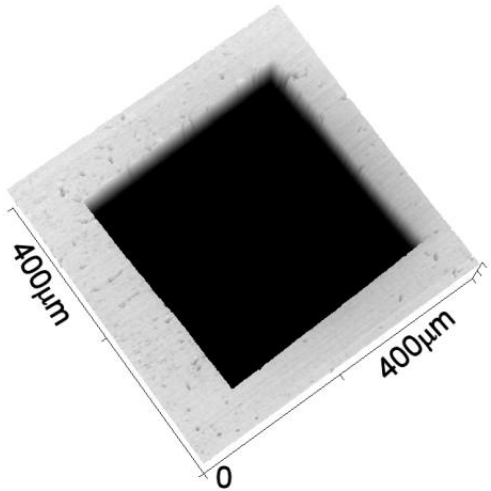
Figure 6. Image at 550 nm wavelength of square hole in Au coated silicon nitride membrane. The lateral side of the image is 400